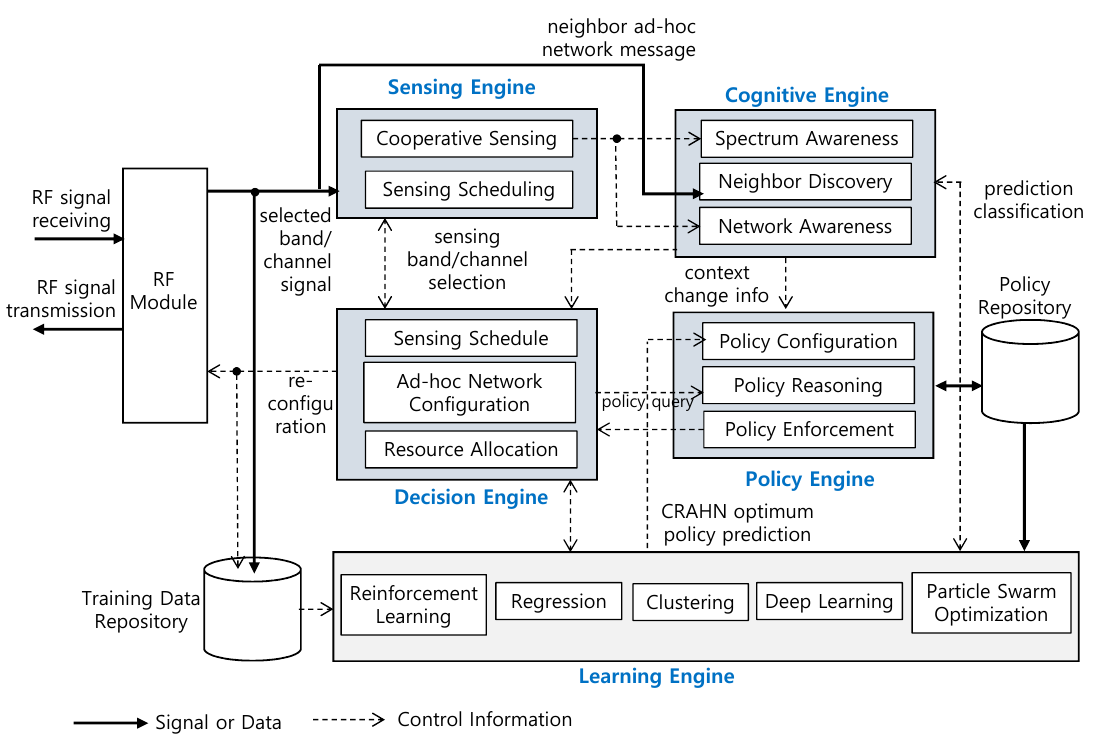
Figure 3. Proposed intelligent CRAHN system model.